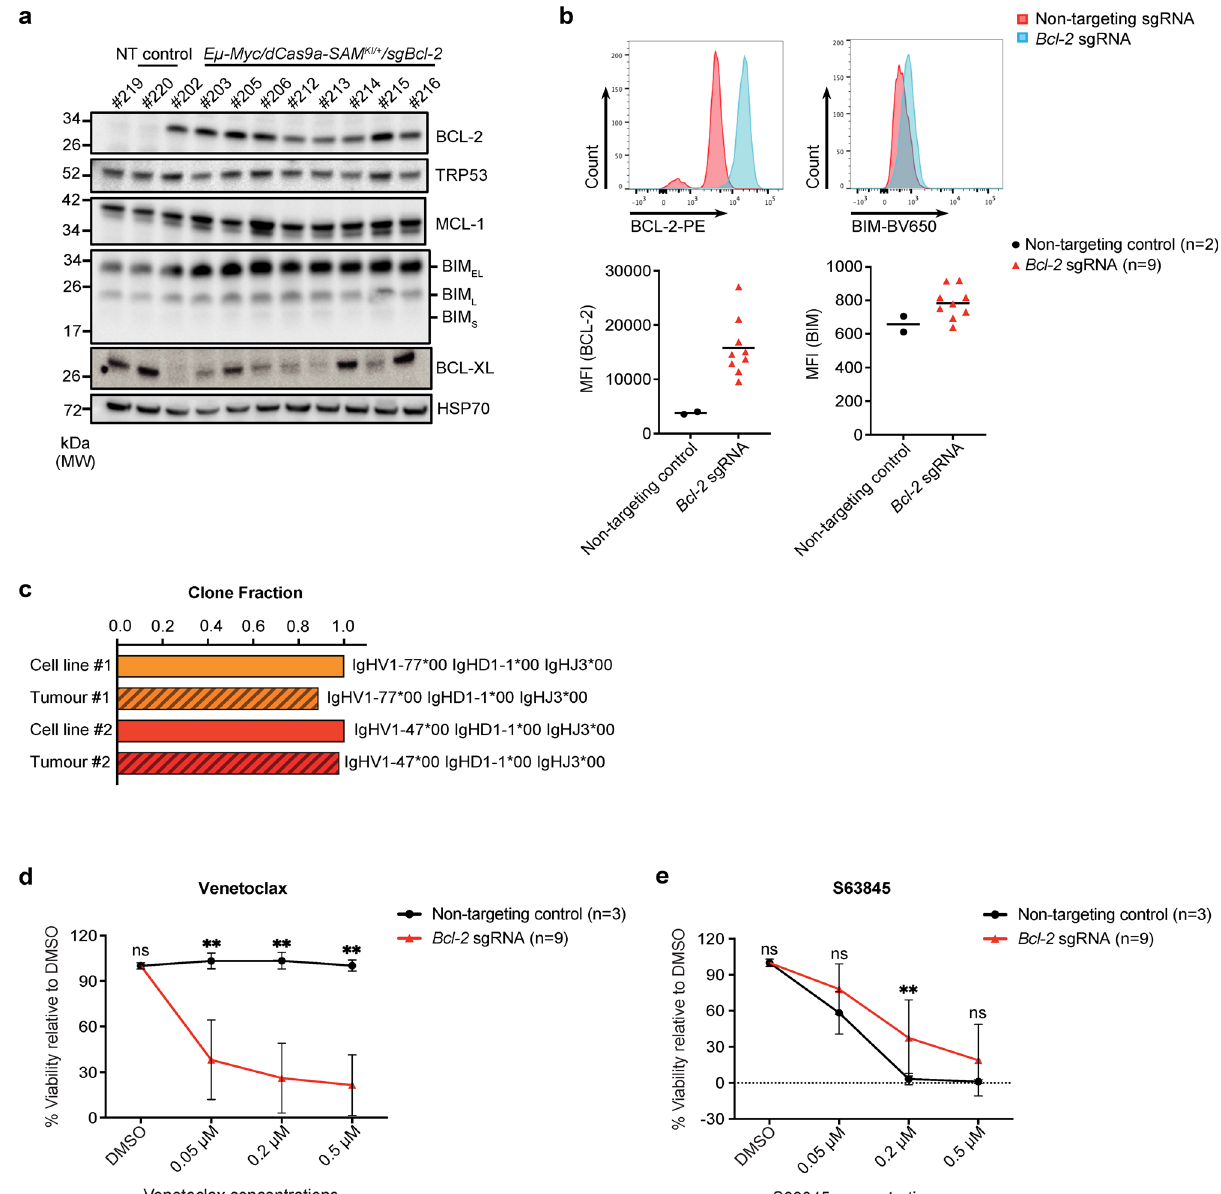
Fig. 5 | Characterisation of E µ -Myc/dCas9a-SAM KI/+ /sgBcl-2 lymphoma-derived celllines.a Theexpression of the indicated proteins in controllymphoma-derived celllinesor E µ -Myc/dCas9a-SAM KI/+ /sgBcl-2 lymphoma-derivedcelllinesisshownby Western blotting. The indicated numbers of the cell lines represent the animal numbersof the mice thatdeveloped lymphomafrom which the celllineshad been derived. Probing for HSP70 served as a protein loading control. 2 independent experiments were performed showing similar results. b The expression of BCL-2 andBIMincelllineswasdeterminedbyintracellularstainingand fl owcytometry.2 control cell lines and 9 E µ -Myc/dCas9a-SAM KI/+ /sgBcl-2 lymphoma cell lines were used for the analysis. Data are represented as the mean MFI of BCL-2 expression ( sgBcl-2 /sgNT)=15,775/3,796; the mean MFI of BIM expression ( sgBcl-2 /sgNT)=